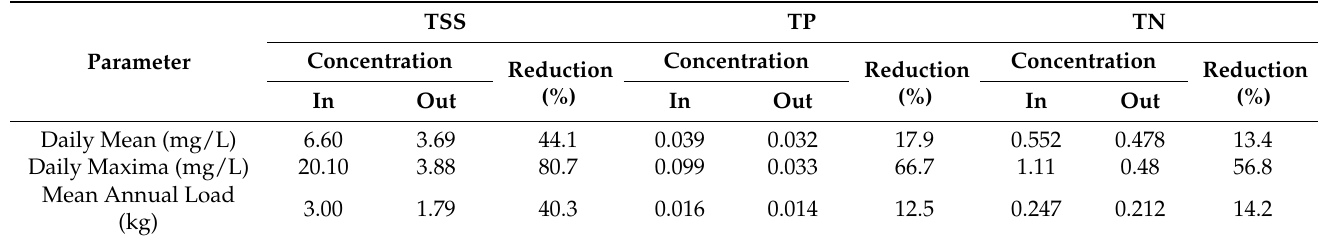
Table 7. Model simulated results with and without